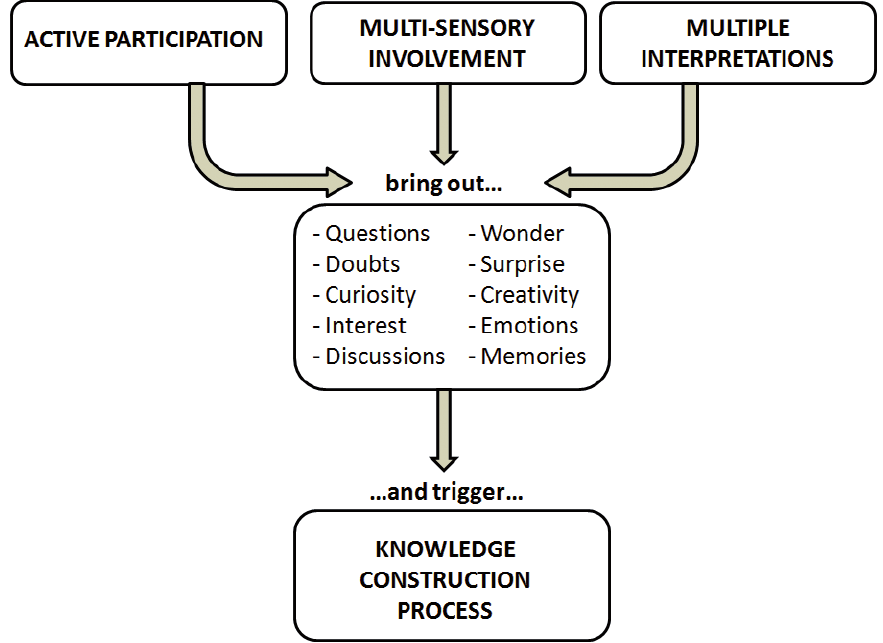
Figure 3. Contribution of interactive activities to the knowledge construction process. This approach is useful to widen the attention from a local to a global scale.